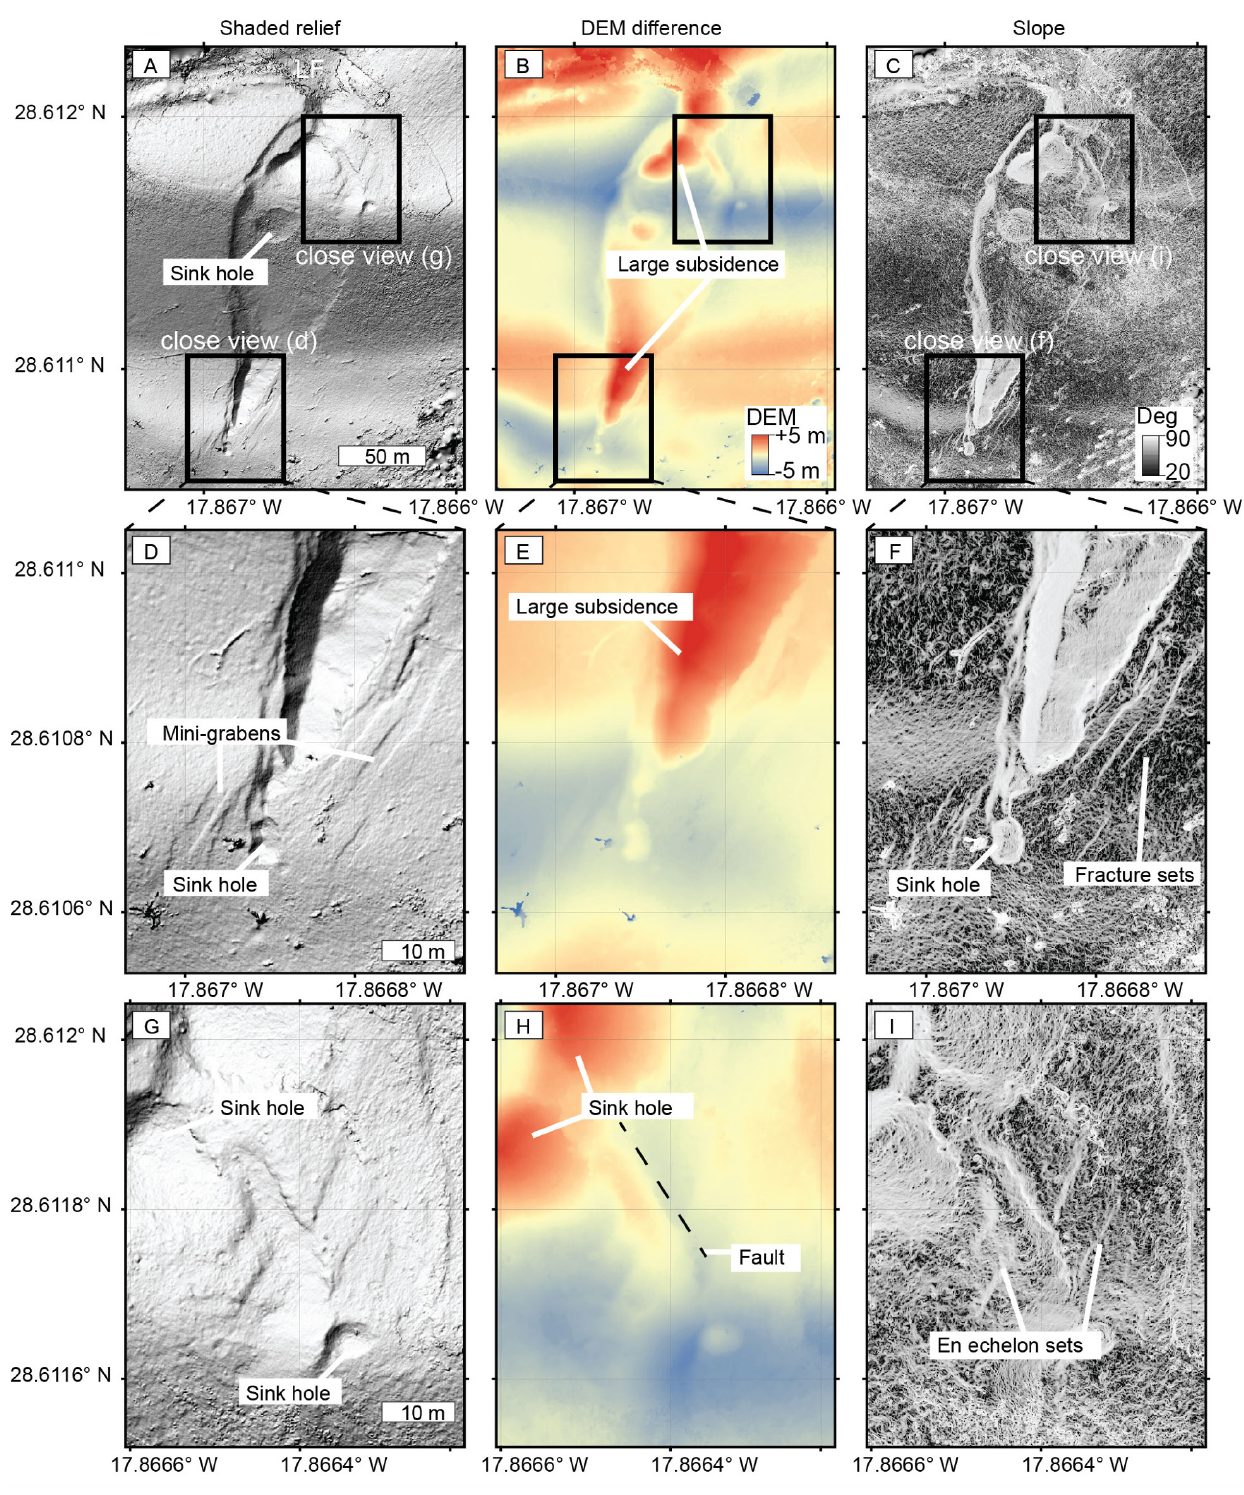
Figure 6: Drone-based results close-up to the lens-shaped fracture as of 05 December 2021, showing the shaded relief maps (left panels), the DEM difference (centre) and the slope maps (right panels). [A, B, C] The fracture is a divergent feature, the largest widening at high topography. Sinkholes appear. [D, E, F] Zoom to the southern edge (for location, see black box), revealing the presence of small sinkholes and subparallel mini-grabens. Vertical difference (middle column) shows that largest subsidence occurs at this place. Slope maps reveal 4–5 subparallel fractures following the trace of the main fault, but with only minor offset. [G, H, I] Zoom to the northeastern edge reveals that the fault is crossed by en-echelon -like fracture sets, here with minor vertical displacement